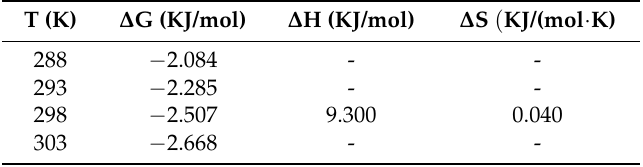
Table 2. Thermodynamic parameters for Cd 2+ sorption onto